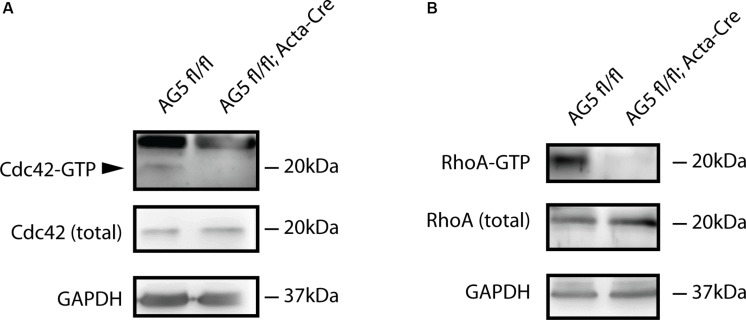
Active forms of Cdc42 and RhoA are reduced by muscle-specific Arhgef5 knockdown. (A,B) Active GTP-bound forms of Cdc42 (A) and RhoA (B) were precipitated from TA homogenates (upper panels) and Cdc42 and RhoA proteins were detected by Western blot from precipitates and tissue lysates (total). GAPDH was used as a loading control.